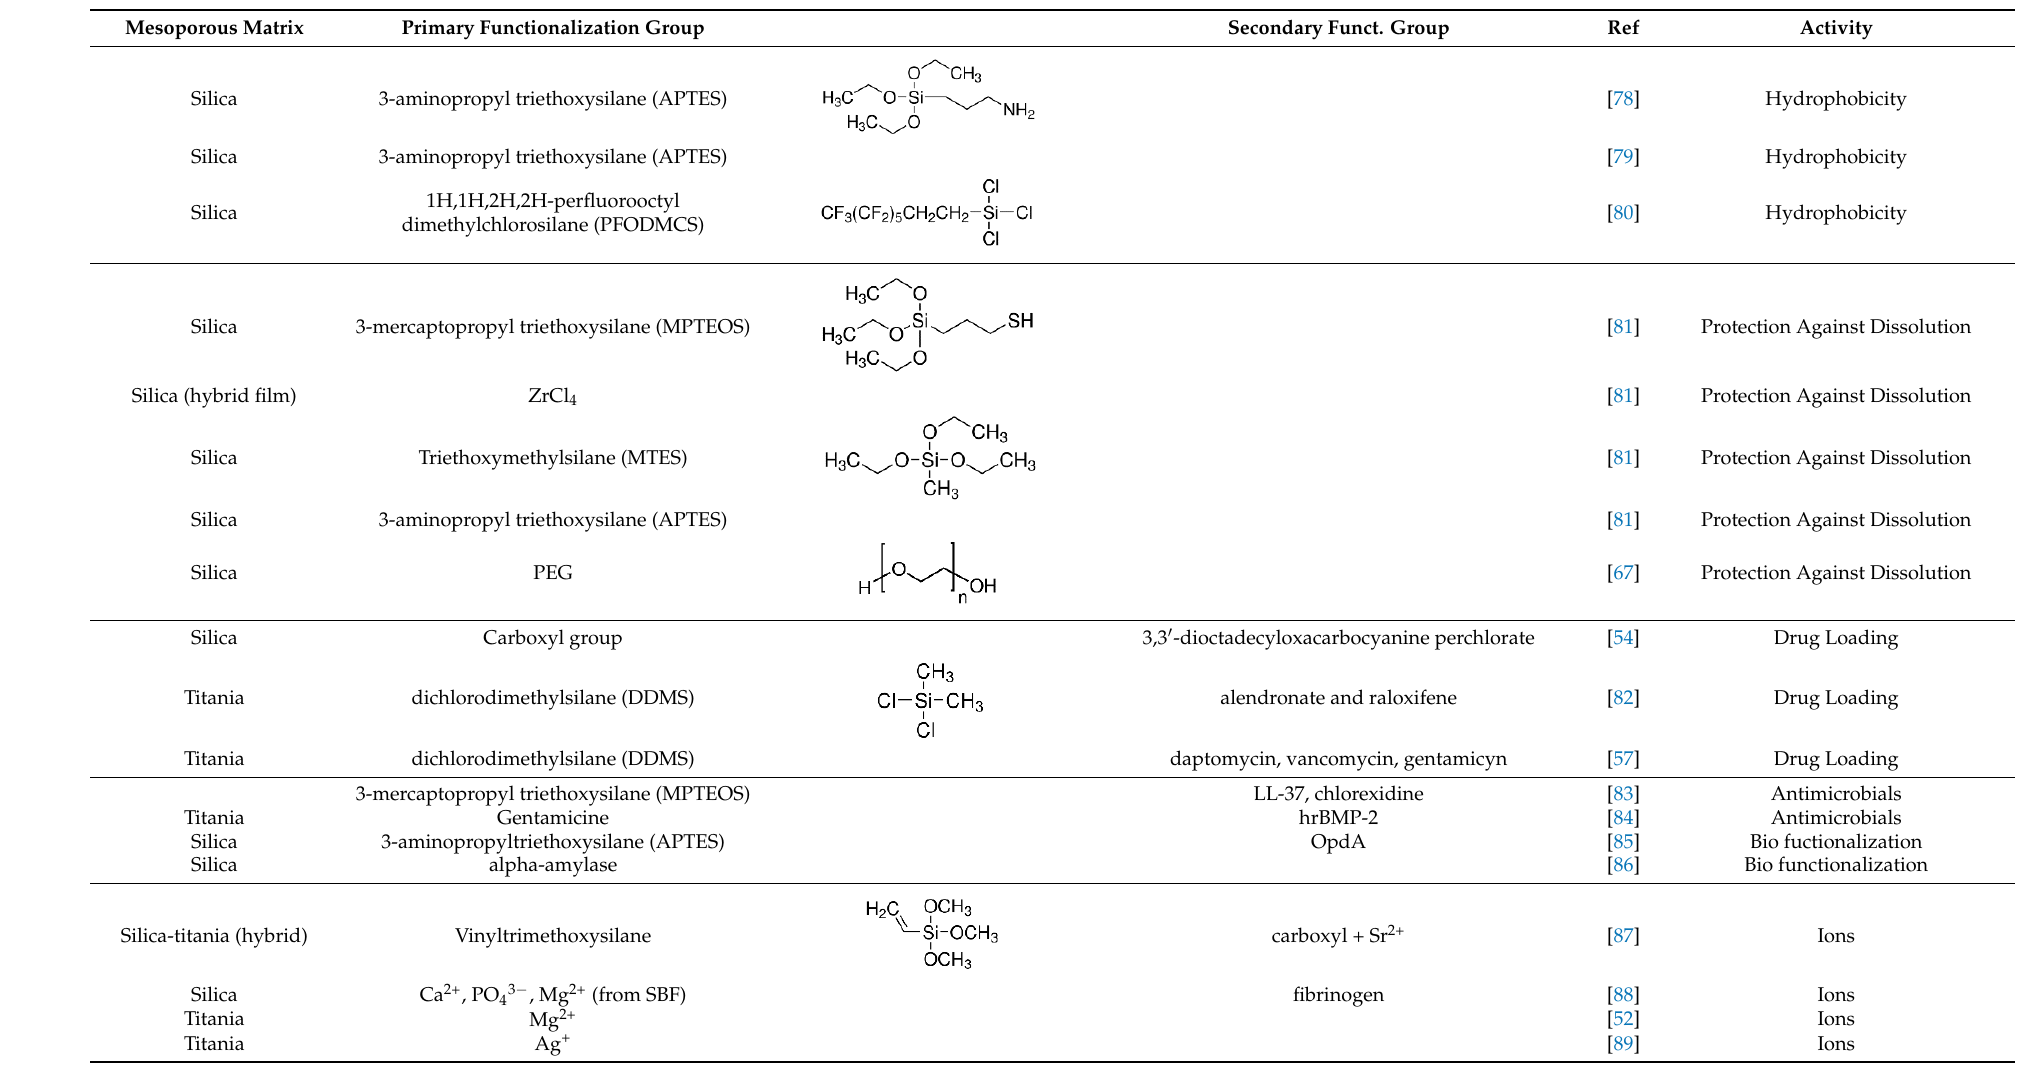
Table 1. Summary of the functionalization groups described in the text, grouped by activity or surface modification.